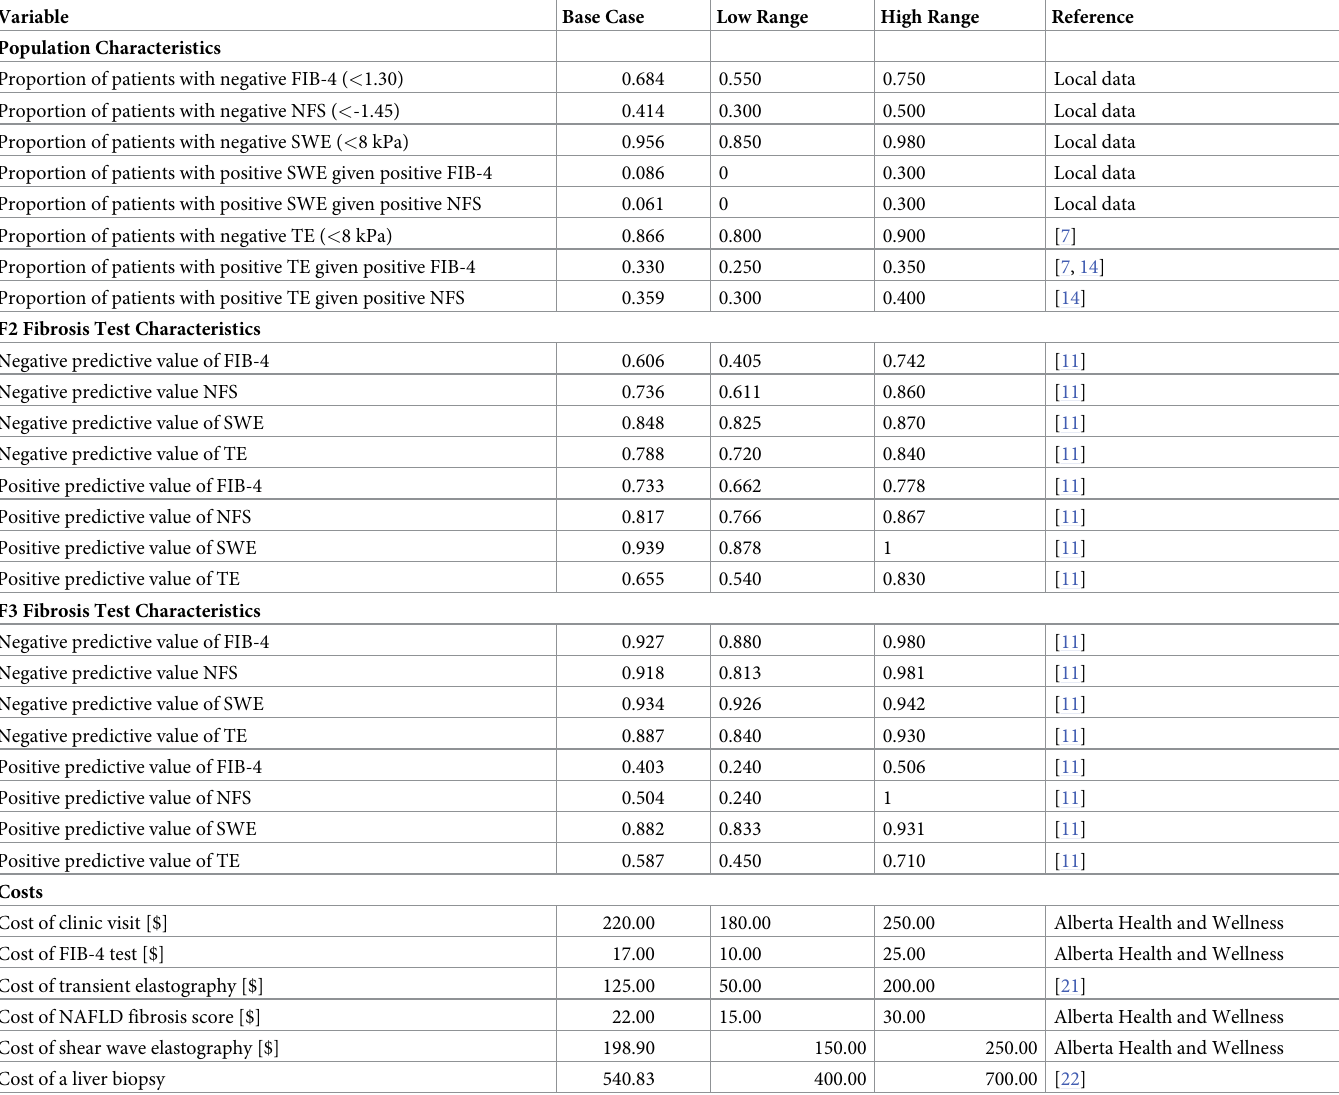
Table 2. Base case scenario analysis